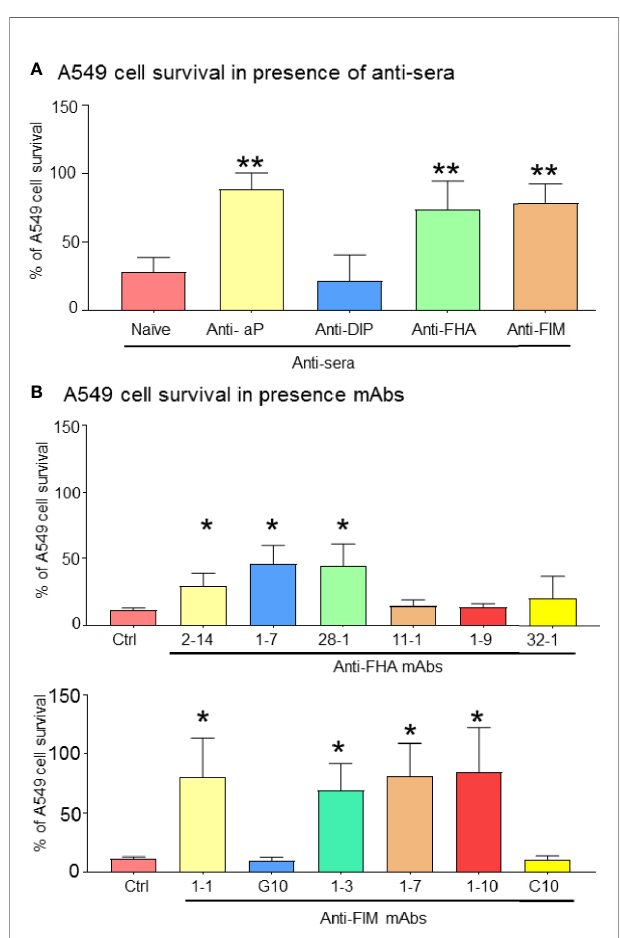
FIGURE 4 | Bacteria aggregation and inhibition of adhesion improve A549 cell survival. After 72 h of infection, remaining adherent A549 cells were stained with Neutral red for cell viability/proliferation. Anti-FIM and anti-FHA anti-sera, which induced B. pertussis aggregation have a bene fi cial impact on A549 cell survival (A) . This observation was reproducible by certain speci fi c anti-FIM and anti-FHA mAbs (B) . Unpaired Student ’ s t-test. Mean ± SEM. *p < 0.05 and **p < 0.01. n ≥ 3